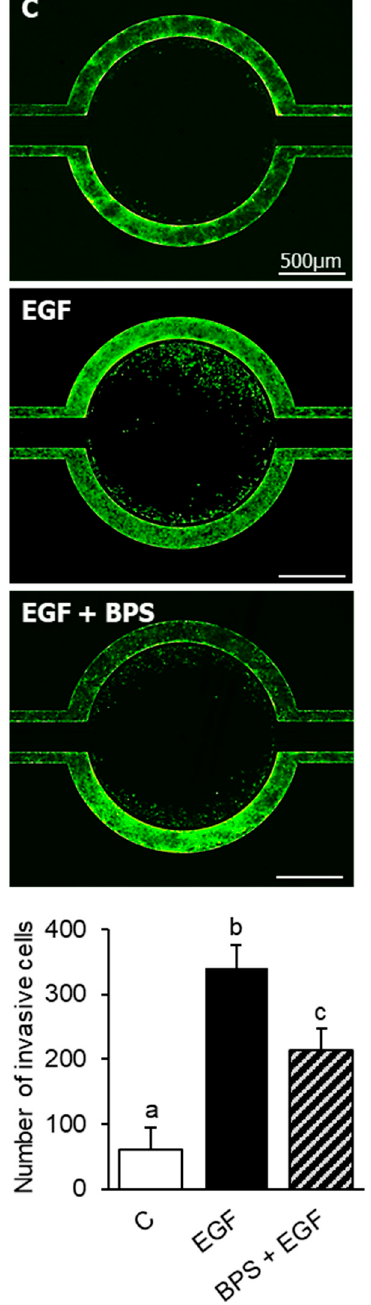
Figure 5. Effect of BPS on HTR-8/SVneo cell invasion using a 3D PDMS microfluidic chip. Representative images ( top ) of invasive HTR-8/SVneo GFP tagged cells, and quantification (mean ± SEM) ( bottom ) following exposure to 0.1% DMSO (control; C), EGF (30 ng/mL), or BPS (1000 ng/mL) + EGF treatments. Quantification (mean ± SEM) is expressed as number of invasive cells. A generalized linear model was used to compare treatments. Different letters denote statistical differences among treatment groups at p < 0.05 ( n = 4 technical replicates/group).